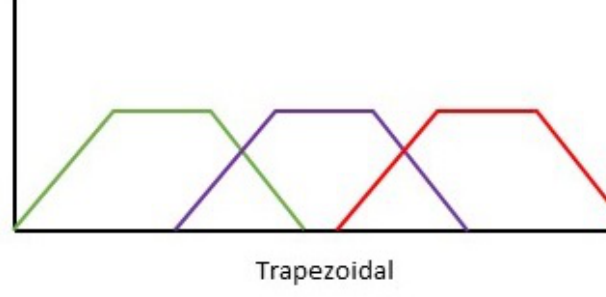
Figure 12. Visual Representation of Trapmf.